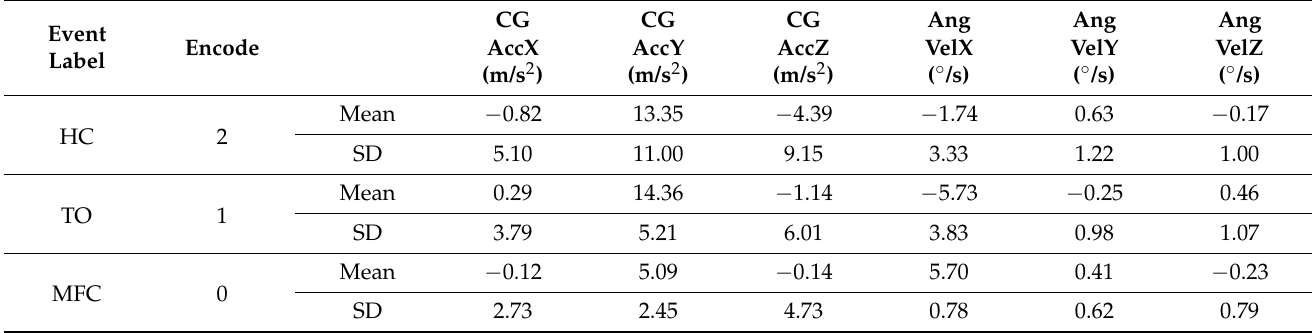
Table 1. Mean and standard deviation of the distribution of the dataset for each label; CGAcc = foot centre of gravity acceleration, AngVel = angular velocity of foot centre of gravity, SD = standard deviation, HC = heel contact, TO = toe-off and MFC = minimum foot clearance.